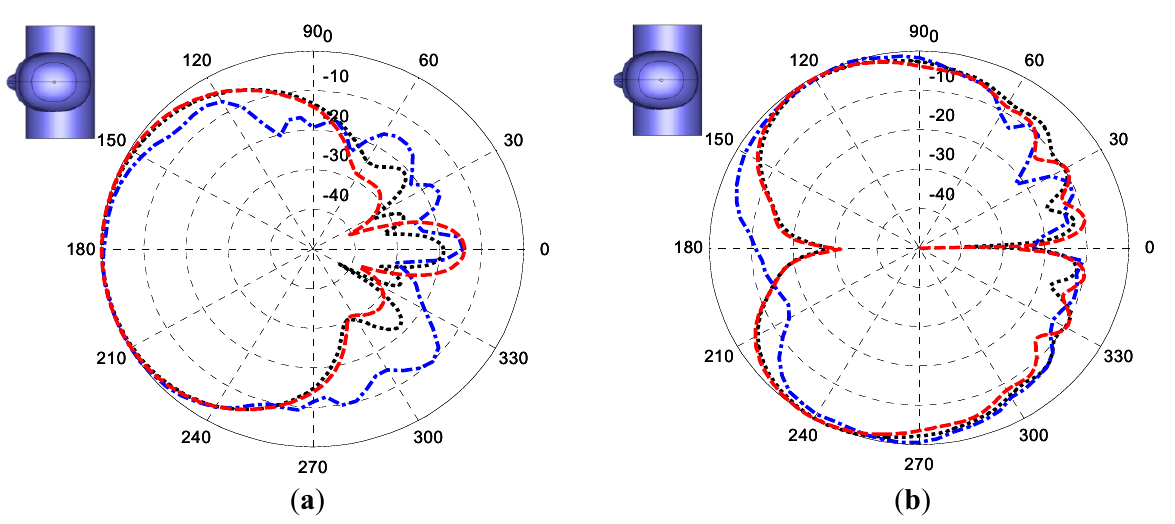
Figure 7. The H-plane cut radiation pattern of the antenna under test (AUT) measured at 2.4 GHz: ( a ) co-polar field component; and ( b ) cross-polar field component.